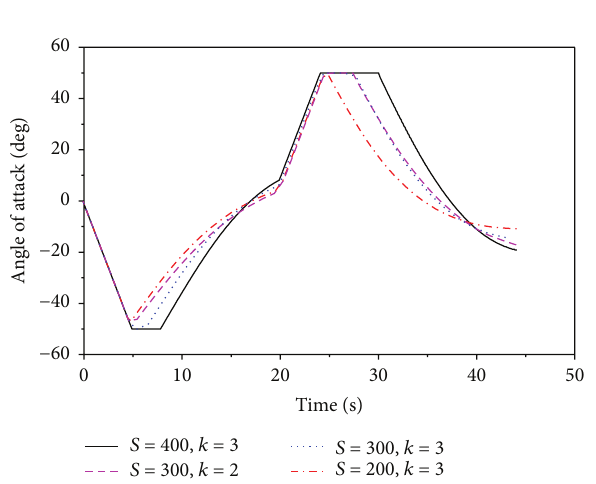
Figure 7: Angle of attack versus